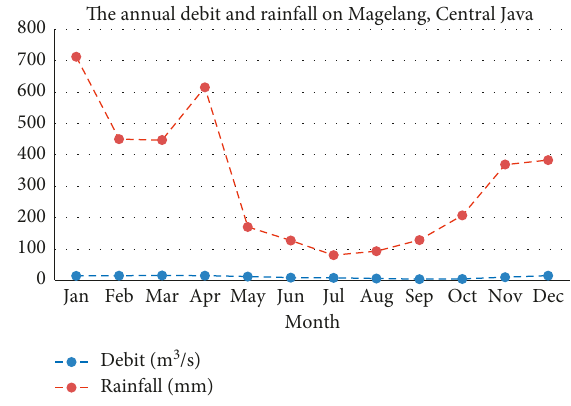
Figure 11: The annual debit and rainfall of Magelang, Central Java, Indonesia.